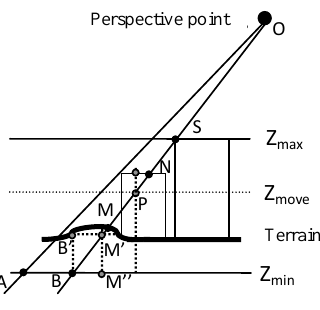
Figure 4. The buildings occlude other